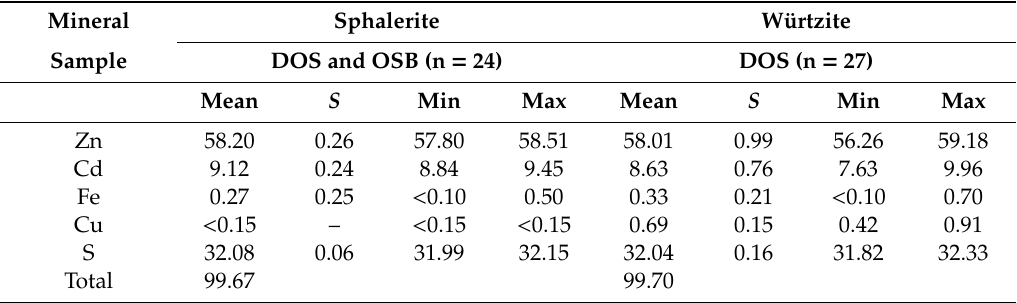
Table 2. Average composition of sphalerite and würtzite from sedimentary rocks (‘oil shales’) of the Muwaqqar Chalk Marl Formation (SEM-EDS and EPMA data, wt%). Mineral Sphalerite Sample